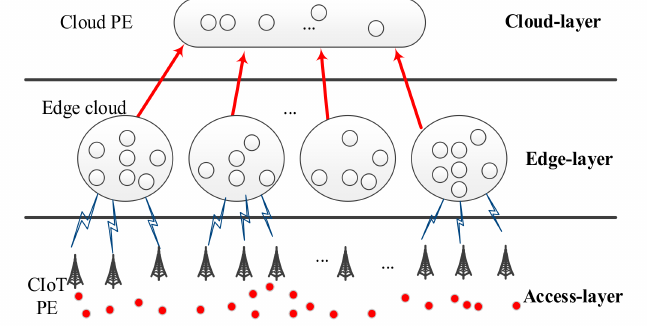
Figure 1. The structure of ECIoT.